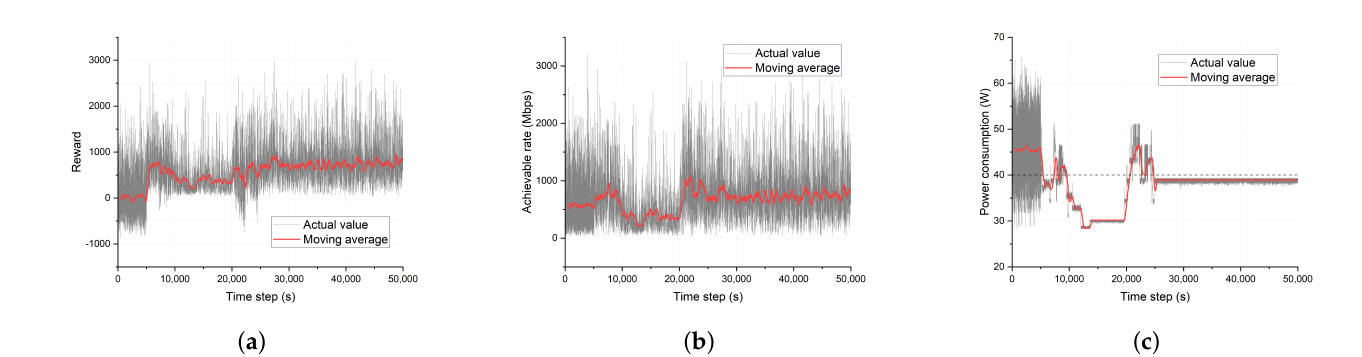
Figure 3. Convergence of the DDPG algorithm. In each subfigure, actual values are shown as grey lines, and red lines represent the moving average of the actual value with a window size 500.